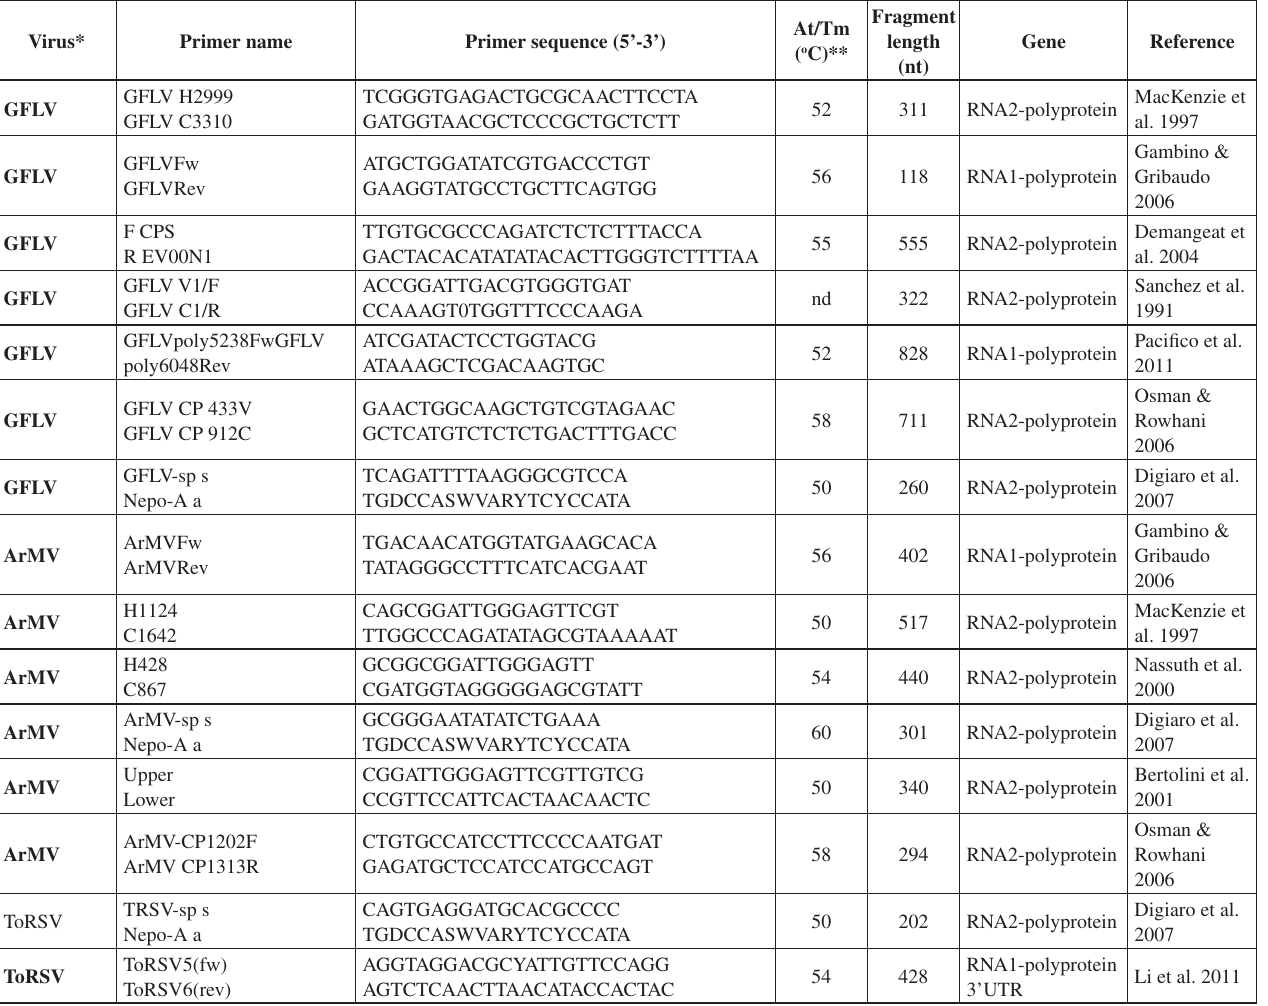
Table 2. Virus-specific